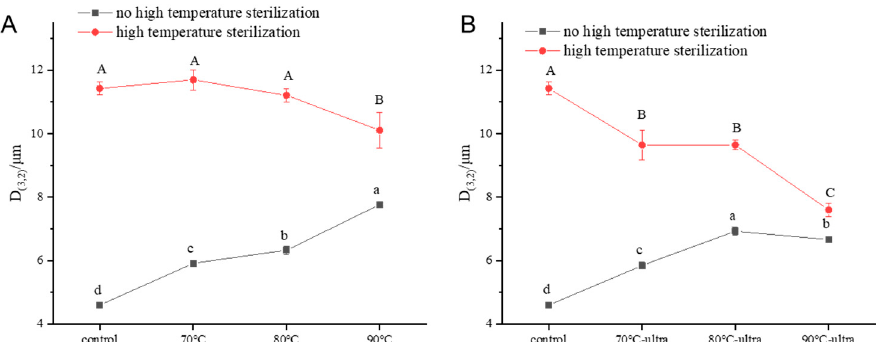
Figure 7. Particle size of different coconut milk samples (( A ): no ultrasound; ( B ): ultrasound, 53 kHz, 40 w / l , 20 min; 70, 80 and 90 °C represent preheating for 20 min; high ‐ temperature sterilization: 135 °C for 60 s). Different letters indicate significant differences at p < 0.05.